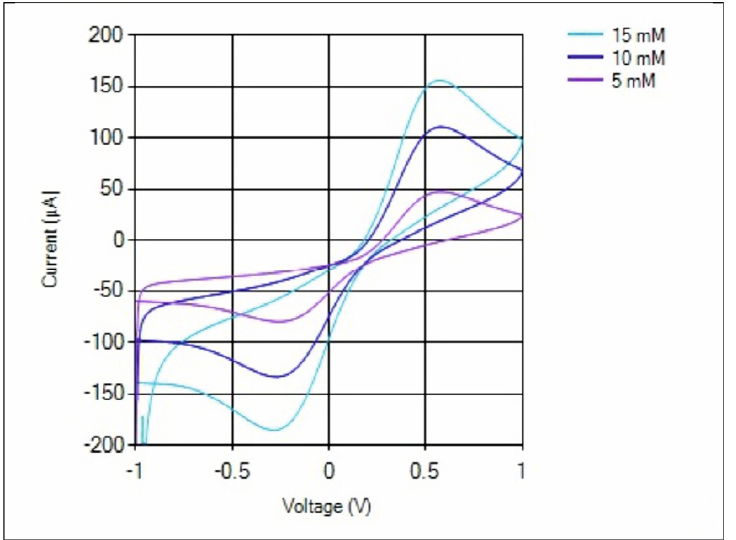
Figure 10. CV measurement on SPCE which had been dripped with 15 mM, 10 mM, and 5 mM Ferricianide K 3 [FE(CN) 6 ] solution .